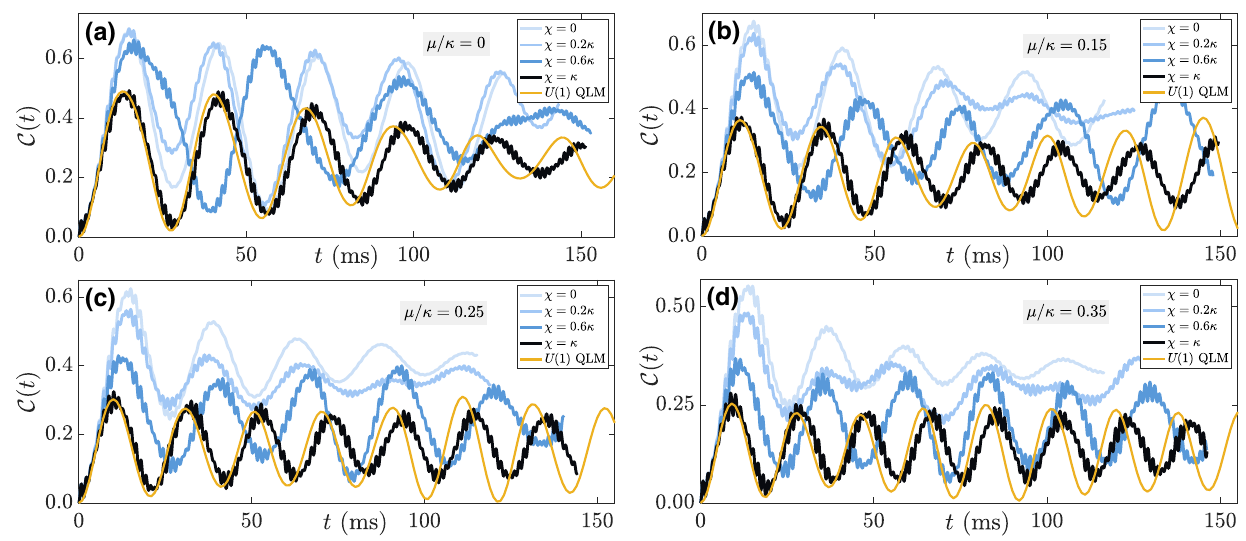
FIG. 6. Same as Fig. 5 but for the chiral condensate (13b). The dynamics is qualitatively different between the deconfined and confined regimes. Whereas for χ/κ = 0 we find dynamics deviating significantly from the initial value of the chiral condensate, as χ/κ is increased, the dynamics exhibits confined behavior with C ( t ) oscillating much closer to 0. For massive quenches, we find that the frequency of oscillations increases with χ , but this is not so clear for the case of μ/κ = 0. This may be related to scars, in that for this quench with χ = 0, the electric flux has half the frequency of the chiral condensate due to the state transfer between the two doubly degenerate vacua during the dynamics; see text and Fig. 5(a). In the confined regime, however, the chiral condensate and the electric flux both exhibit the same